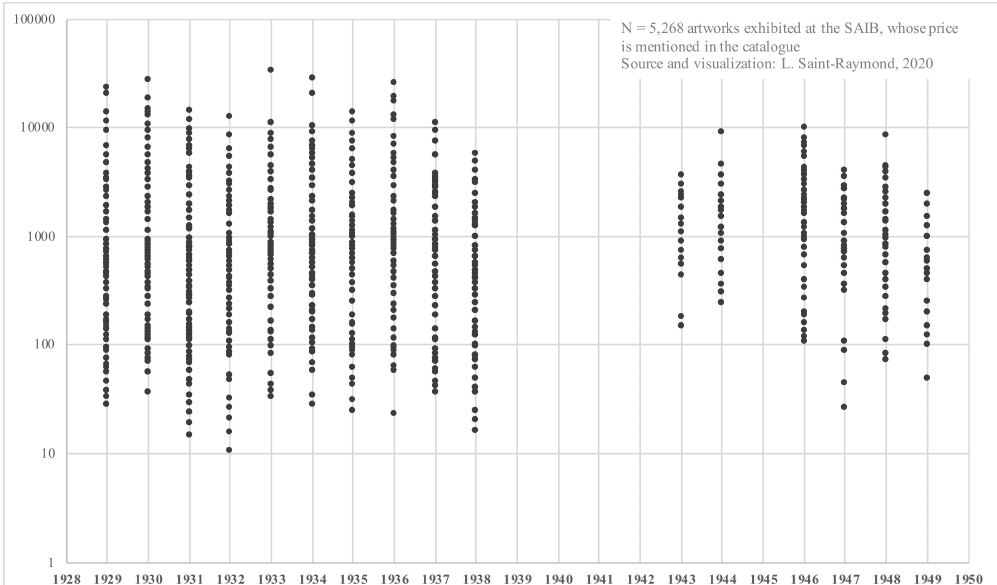
Figure 10. Price distribution of the artworks exhibited by the Artistes indépendants bordelais (AIB) or their guests,